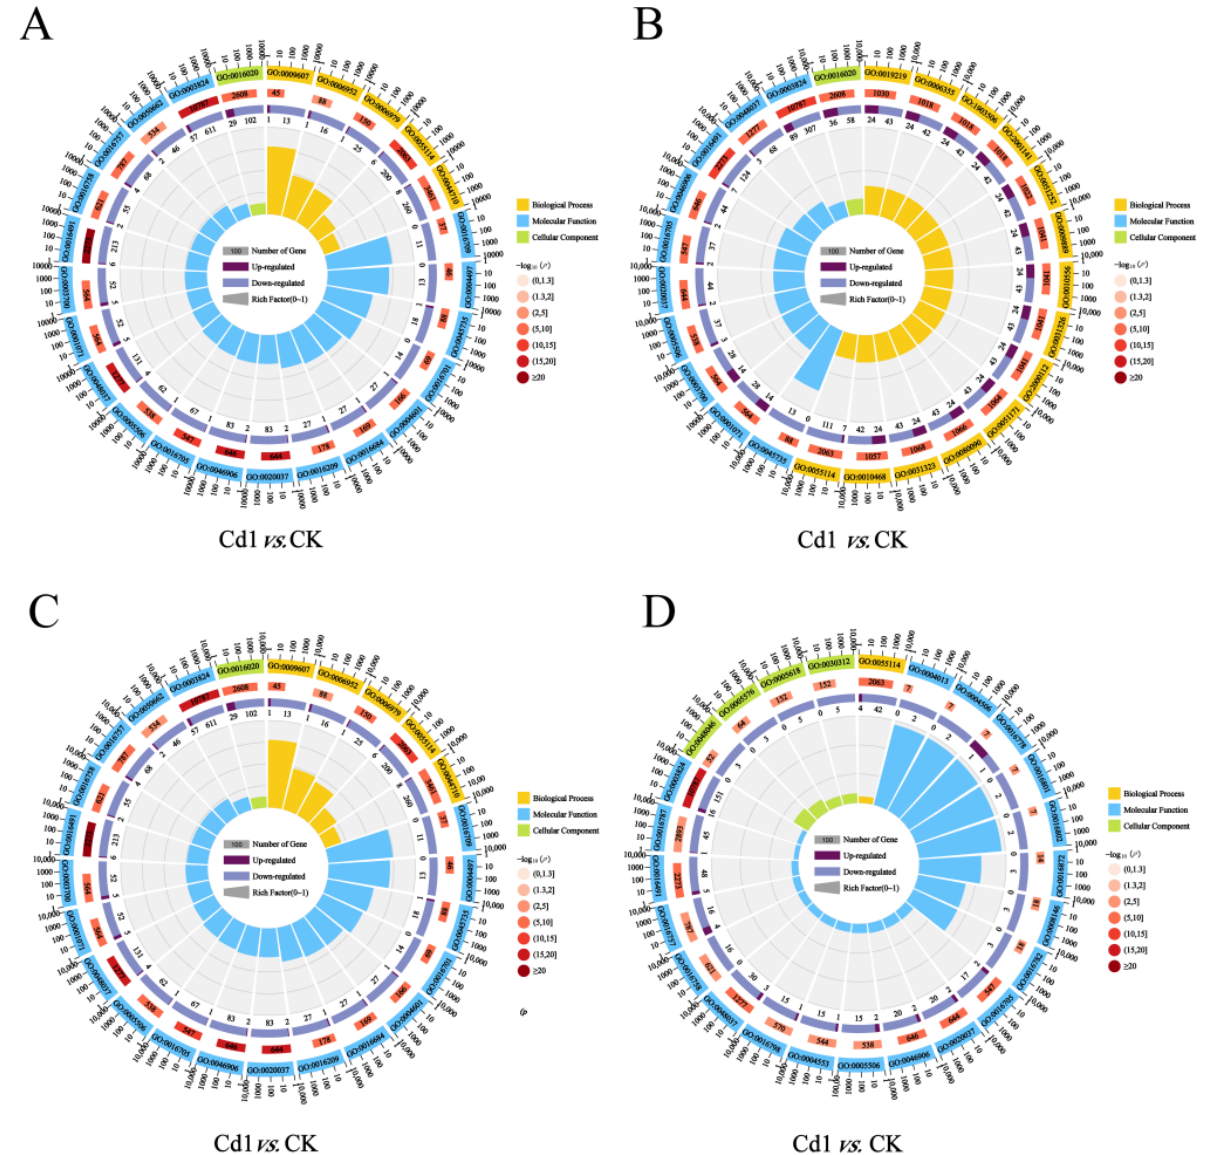
Figure 3. Identification and GO enrichment of DEGs. ( A – D ) Top 25 GO enrichment results of DEGs in different pairwise comparisons. ( A ) Cd1 vs. CK; ( B ) Cd2 vs. CK; ( C ) As1 vs. CK; ( D ) As2 vs. CK. CK, control group; Cd1 and Cd2 indicate the tea roots treated with Cd for 10 and 15 days, respectively; As1 and As2 indicate the tea roots treated with As for 10 and 15 days, respectively.